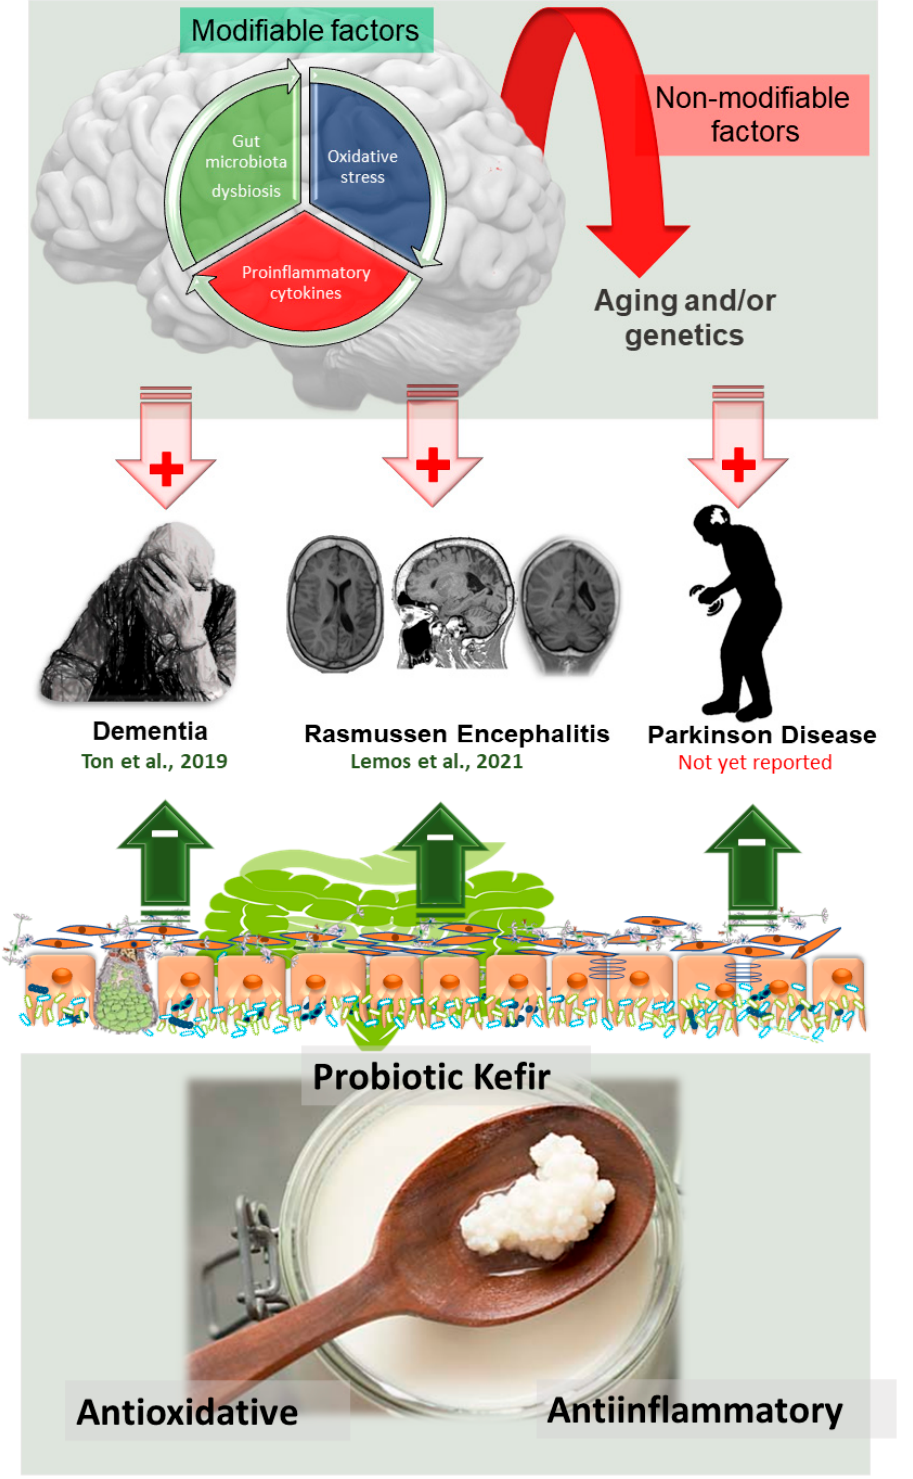
Figure 5. Graphical scheme demonstrating the state-of-the-art and our conclusive opinion based on our clinical studies performed in patients suffering from aging-related dementia and AD and in young patients exhibiting repeated and intense episodes of seizures. It should be noted that the role of kefir in PD progression has not yet been reported in the